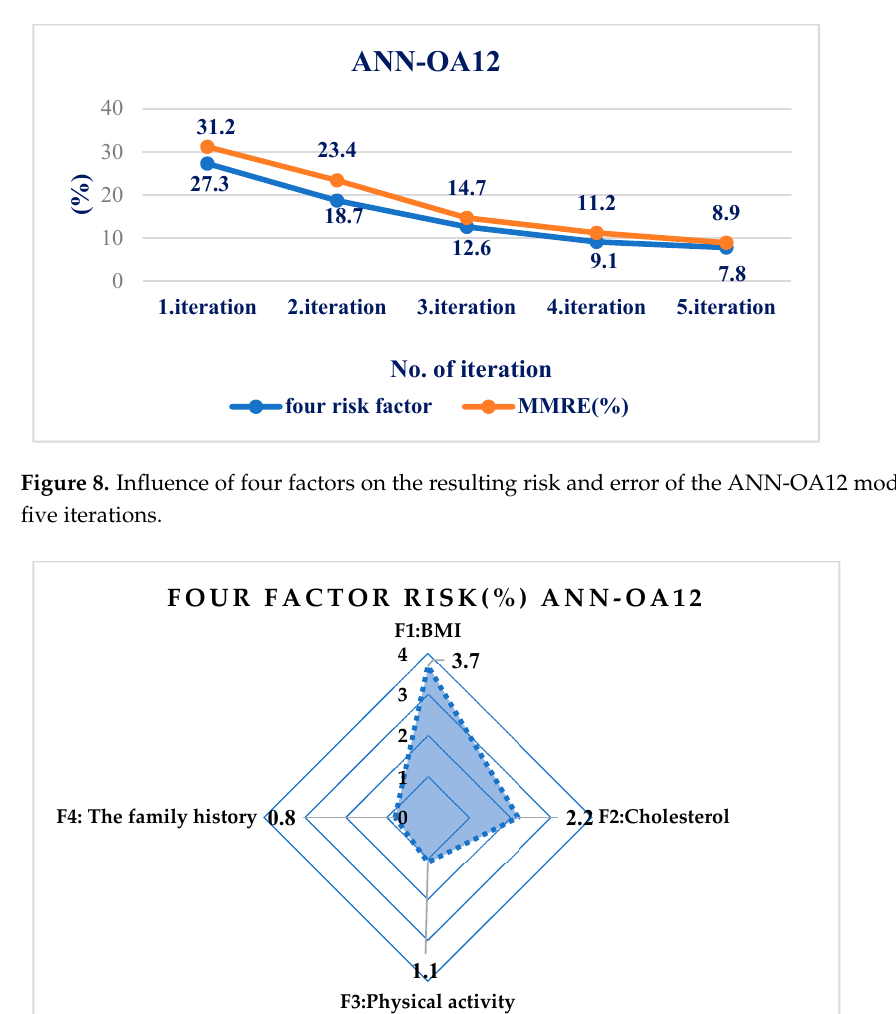
Figure 9. Influence of four risk factors on ANN-OA12.